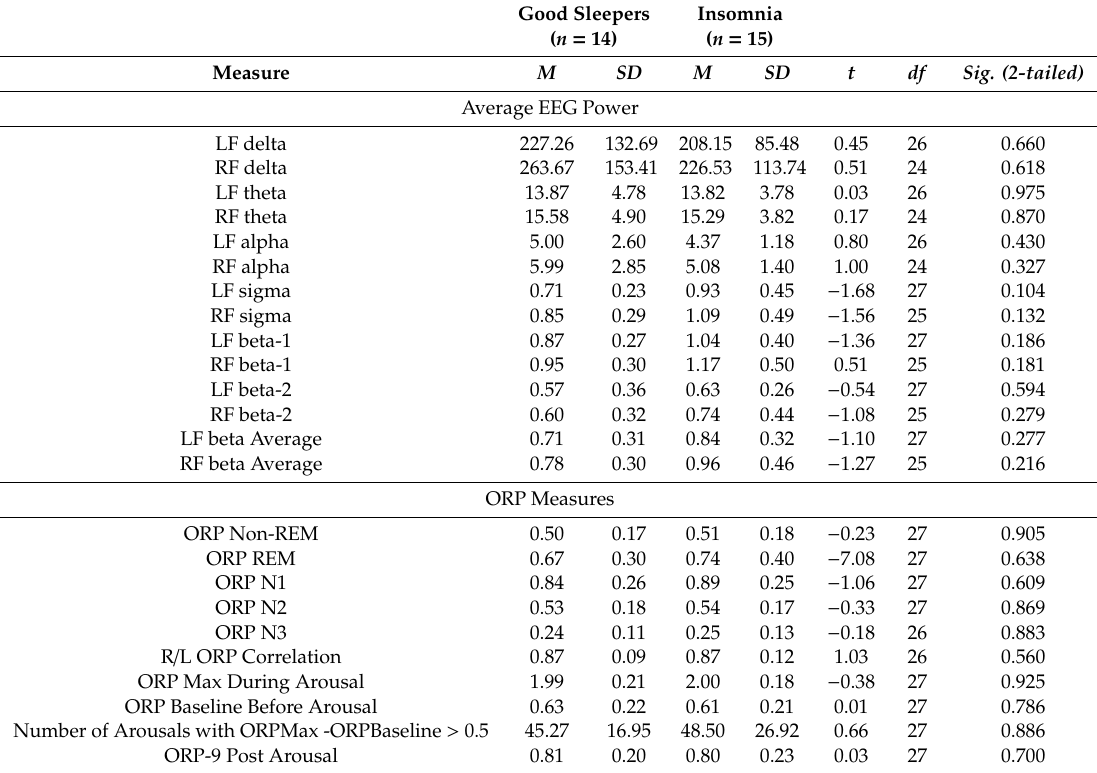
Table 3. Group comparisons and means and standard deviations for quantitative EEG parameters of